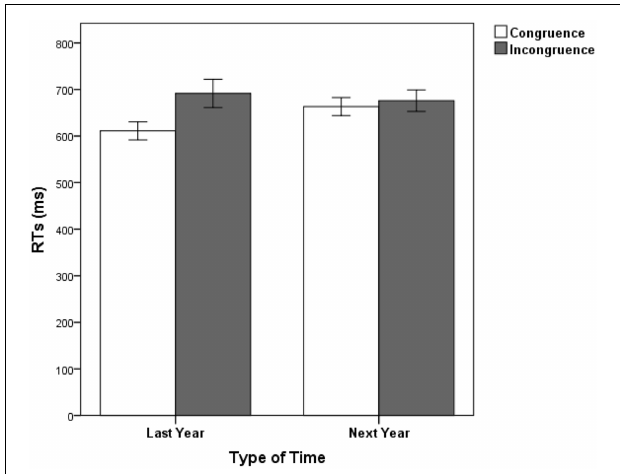
FIGURE 2 | Mean RTs in Experiment 2 as a function of type of time and response congruence. Error bars represent standard errors of the means.